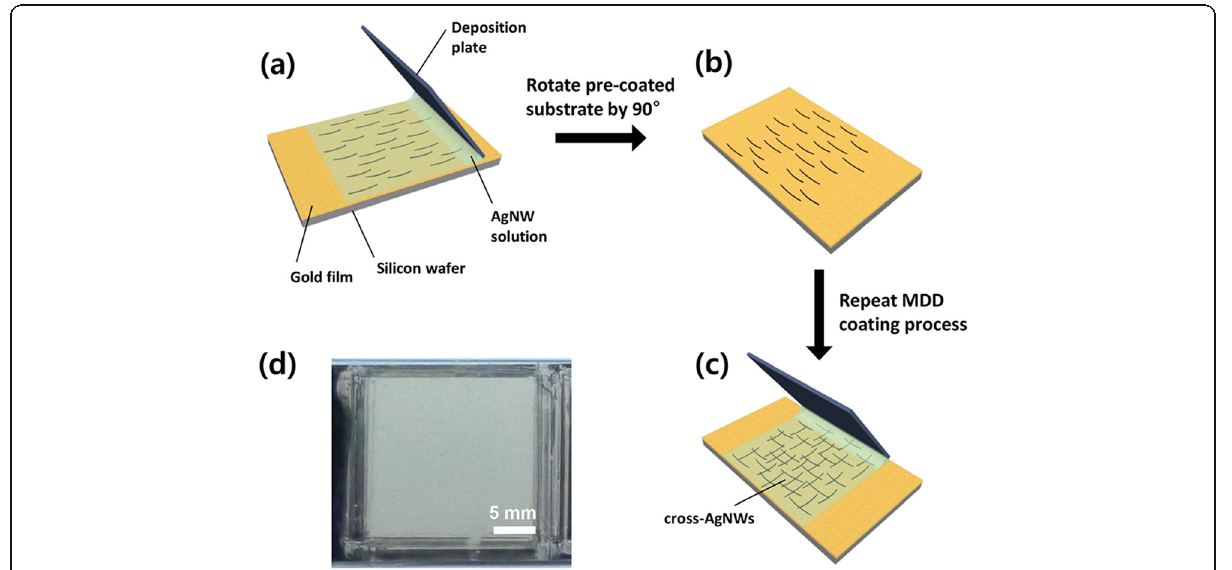
Fig. 1 a – c Schematic illustration of MDD coating process for fabricating the cross-AgNW films on a gold surface. d Photograph of the cross-AgNW films with deposition number of